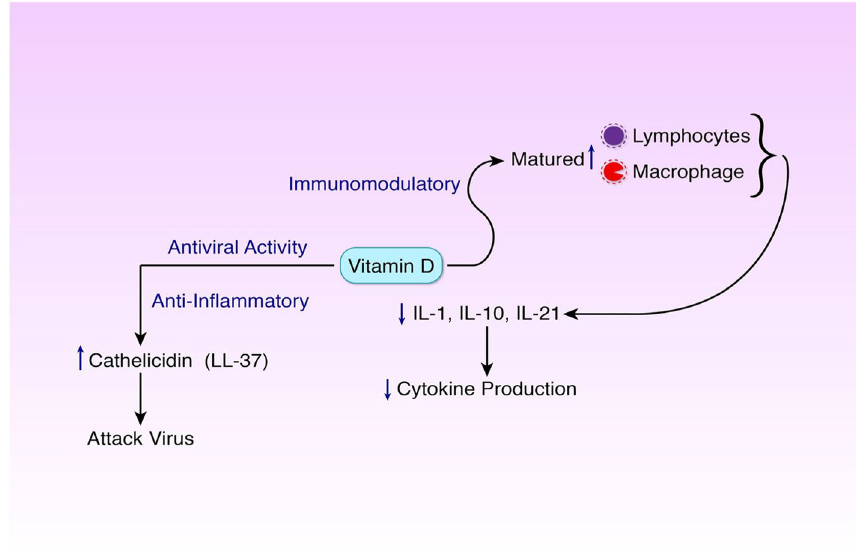
Fig. 2 Vitamin D. It has three activities. a It has immunomodulatory activity. Here, it matures lymphocytes and macrophage. b Its anti-inflammatory activity decreases the level of IL-1, IL-10, and IL-21. As a result, the level of cytokine decreases. c In its antiviral activity, vitamin C increases the level of cathelicidin (LL-37) which attacks viruses. Vitamin D helps to protect the body from diseases and reduce the severity of